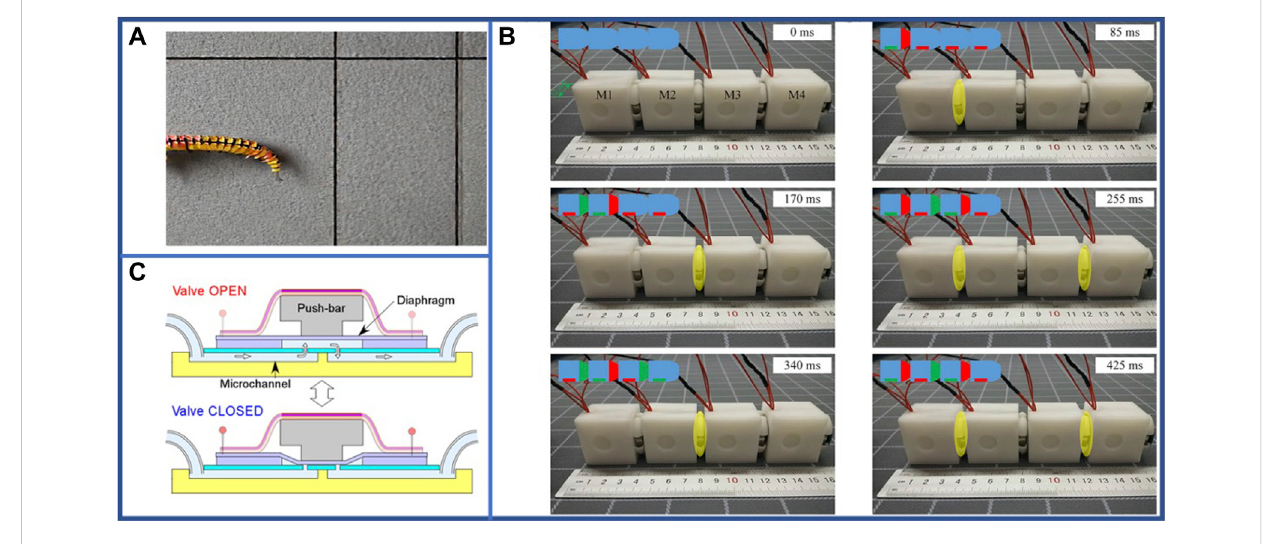
FIGURE 3 Some cutting-edge ideas based on earthworms. (A) Earthworm-inspired wall crawling robot attached to vertical walls. (B) Modular wall crawling robotusingelectromagneticeffectanditsmovementprocess(Zhangetal.,2021a).FromRef.(Zhangetal.,2021a),usedunderCreativeCommonsCC-BY license. (C) A valve powered by earthworm muscle with chemical control (Tanaka et al., 2019). From Ref. (Tanaka et al., 2019), used under Creative Commons CC-BY license.